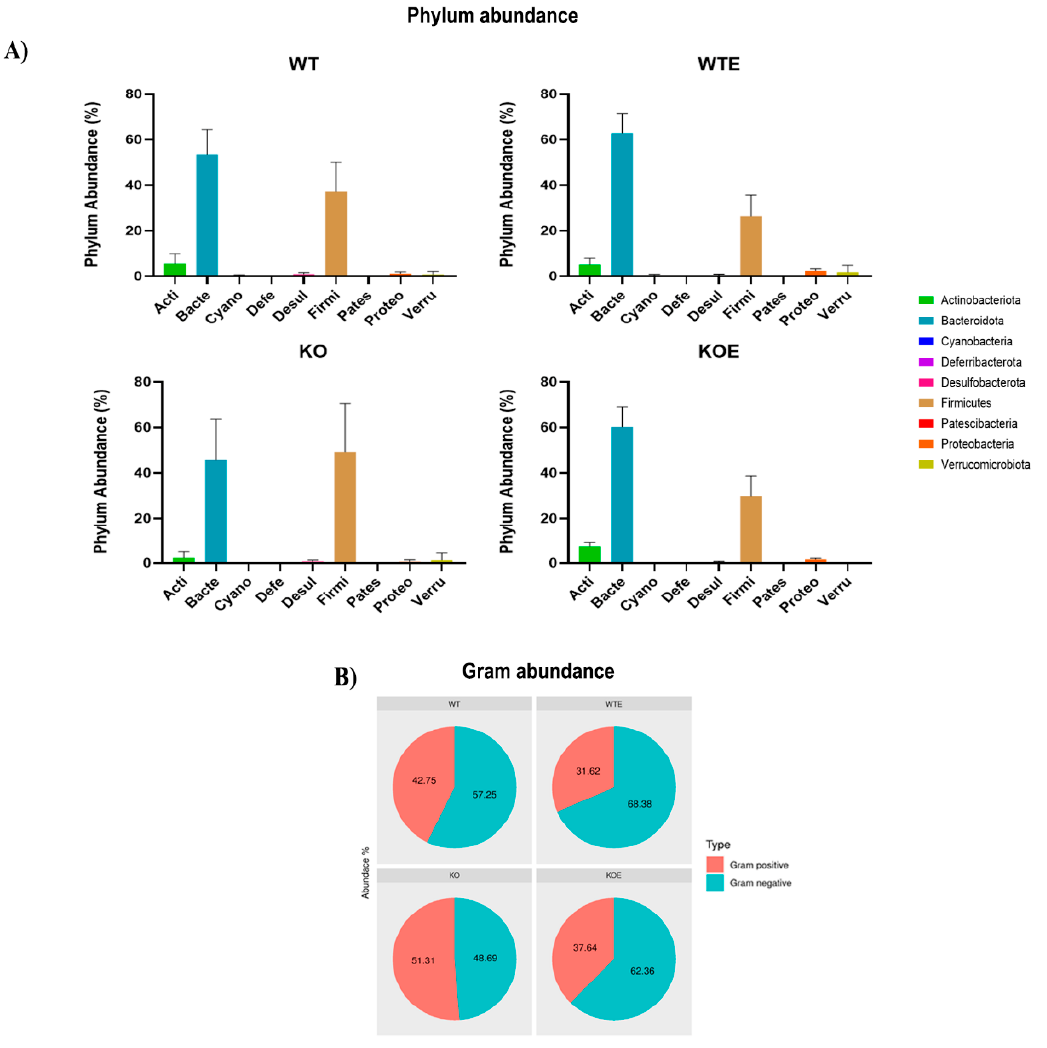
Figure 4. Microbiota composition of each group and changes among them. ( A ) Average phylum abundance in each group, where the dominance of phyla Firmicutes and Bacteroidota phyla is seen. ( B ) Pie charts depicting the average Gram-positive and Gram-negative abundance in the four groups.